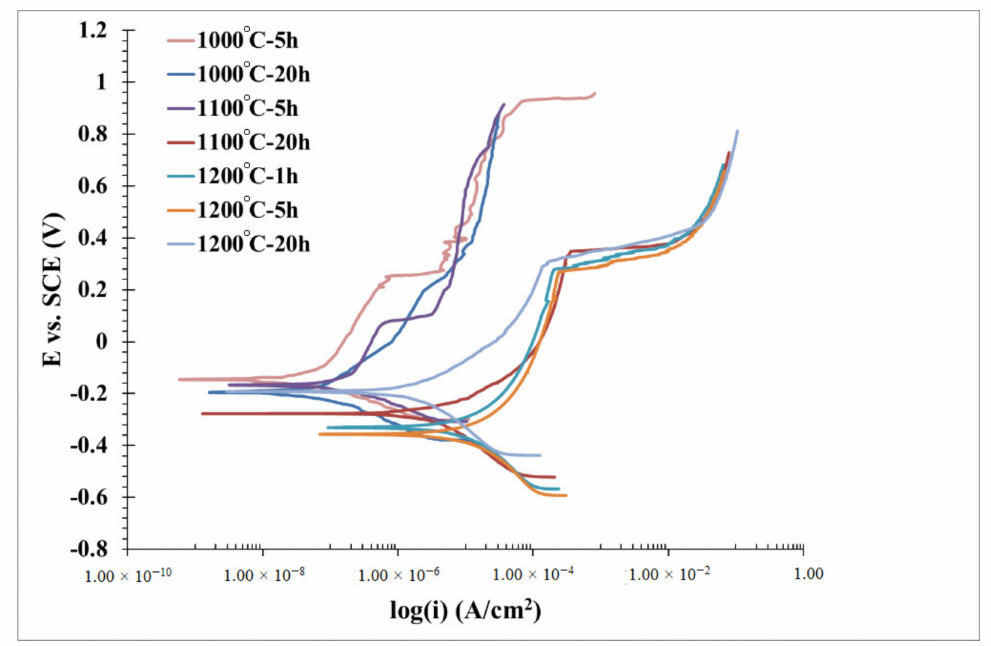
Figure 7. Potentiodynamic polarization curves for the OPH1 samples in a 3.5% NaCl aqueous solution with di ff erent heat treatment